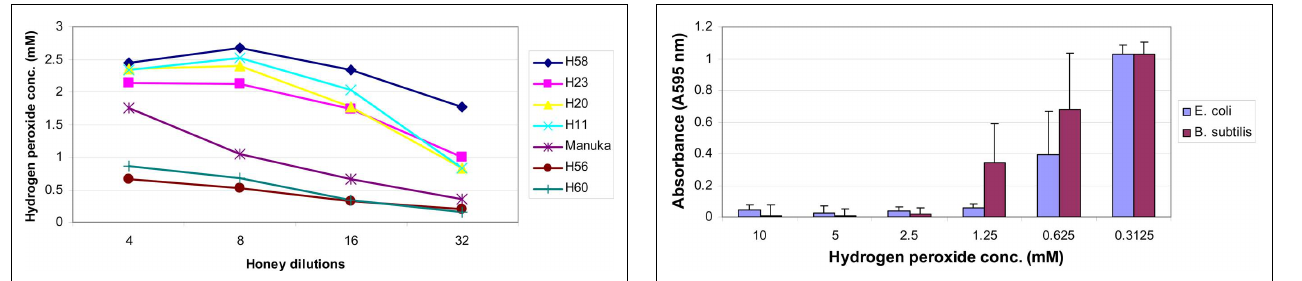
FIGURE 2 | Effect of increasing the concentration of exogenous hydrogen peroxide on the growth of E. coli (blue line) and B. subtilis (red line). Each point represents the mean and SD of three separate experiments conducted in